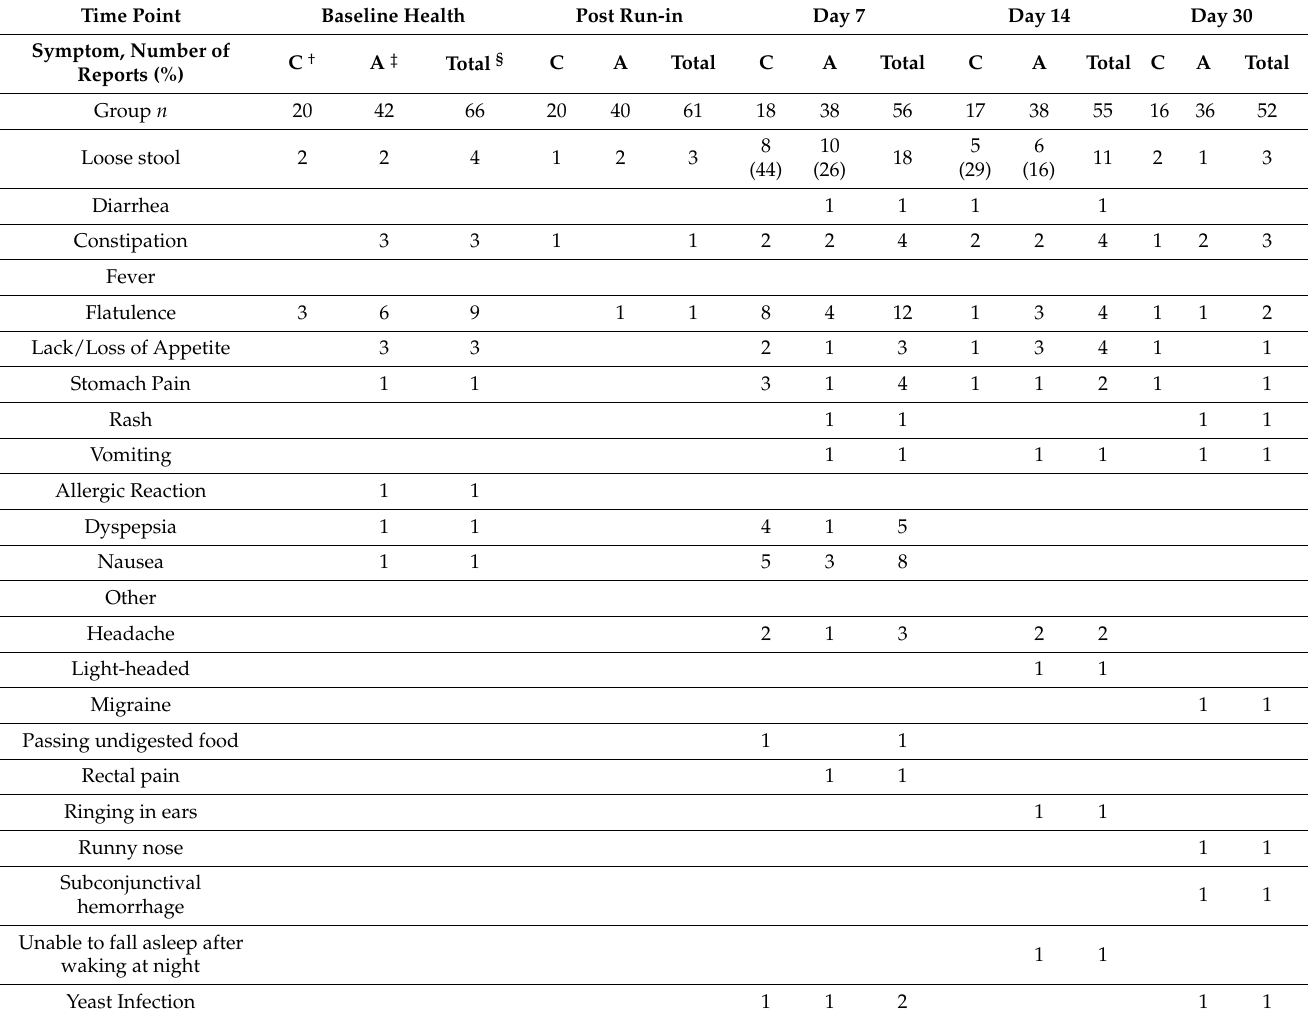
Table 3. Clinical symptoms by time